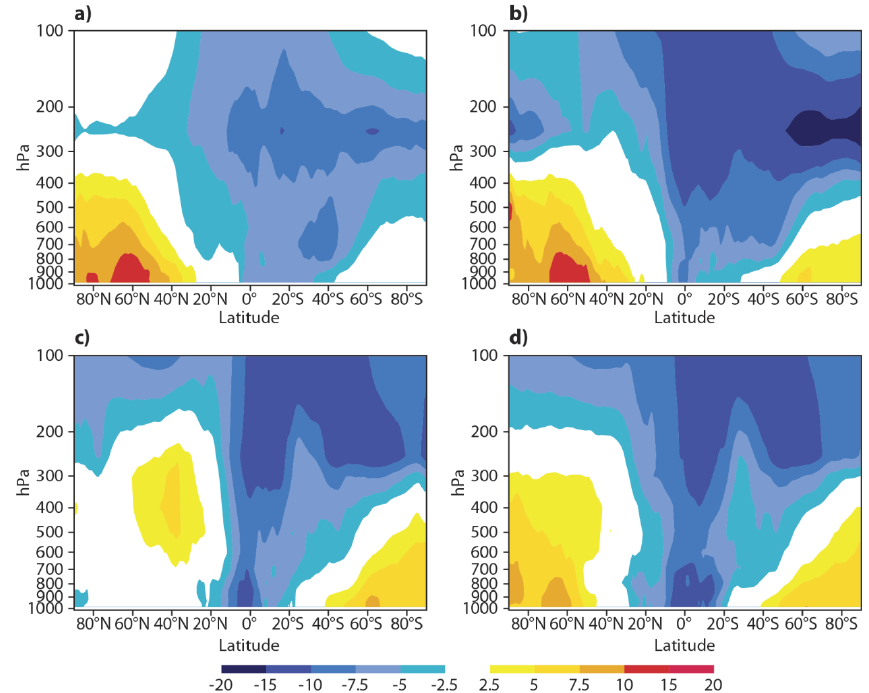
Figure 4. Cross sections of the seasonal mean zonal mean CO differences between CIFS-AN minus CIFS-CTRL in ppb for (a) JF, (b) MAM, (c) JJA and (d) SON 2008. Red indicates positive values, blue negative